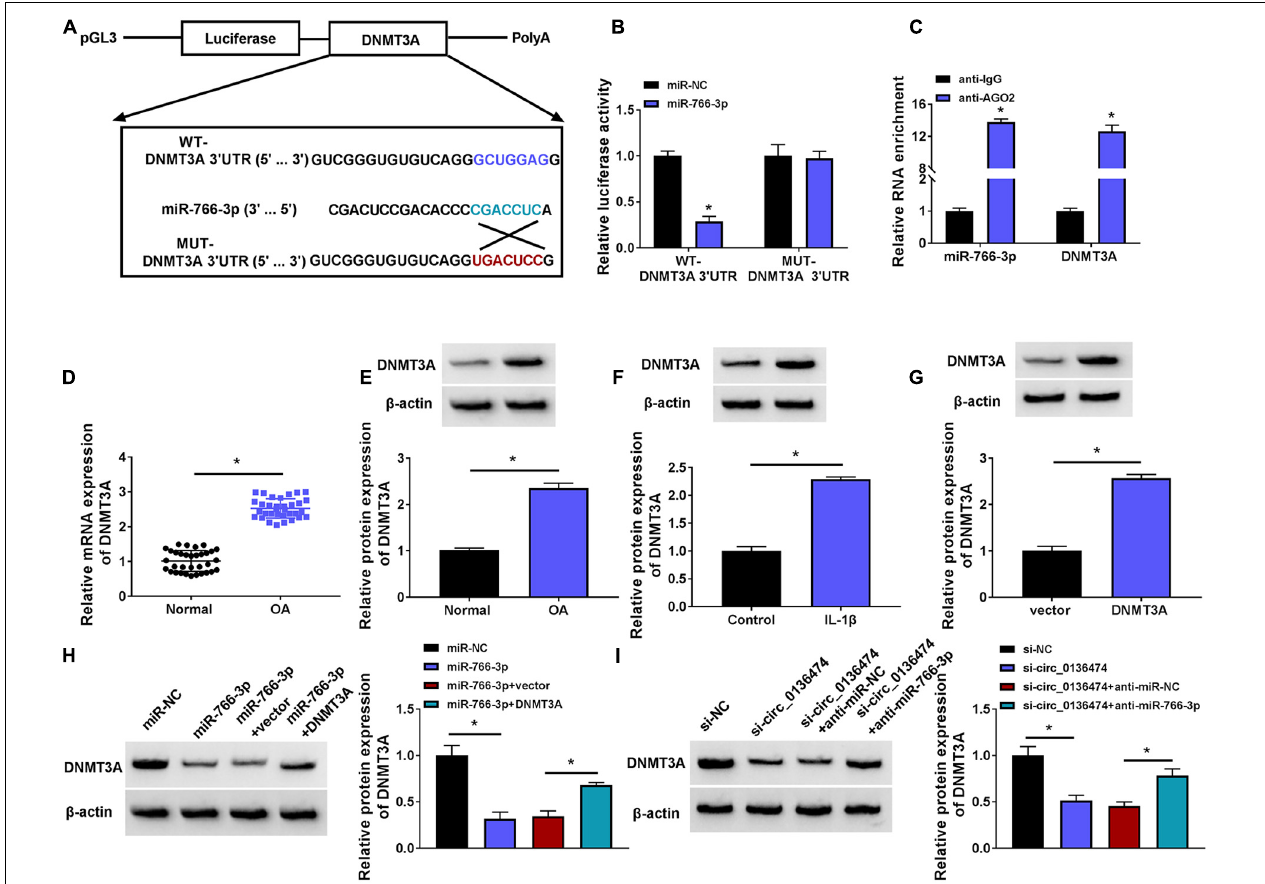
FIGURE 6 | DNMT3A was a target gene for circ_0136474/miR-766-3p. (A) Schematic diagram showing the construction of pGL3 luciferase report vectors carrying WT-DNMT3A 3’UTR or MUT-DNMT3A 3’UTR. (B) Dual-luciferase reporter assay measured the relative luciferase activity of WT-DNMT3A 3’UTR and MUT-DNMT3A 3’UTR vectors with co-transfection with miR-766-3p/NC in CHON-001 cells. (C) RIP assay confirmed the relative RNA enrichments of DNMT3A and miR-766-3p in CHON-001 cells. (D) qPCR detected the relative mRNA expression of DNMT3A, and (E–I) Western blotting examined the relative protein expression of DNMT3A in (D,E) OA cartilages ( n = 33) and normal cartilages ( n = 33), (F) control CHON-001 cells and IL-1 β (10 ng/ml)-induced CHON-001 cells, (G–I) IL-1 β (10 ng/ml)-induced CHON-001 cells pretransfected with DNMT3A vector or empty pcDNA vector (vector), miR-766-3p/NC or miR-766-3p combined with DNMT3A or vector, si-circ_0136474/NC or si-circ_0136474 combined with anti-miR-677-3p or anti-miR-NC. * P < 0.05 was determined by unpaired t -test, ordinary one-way ANOVA or two-way